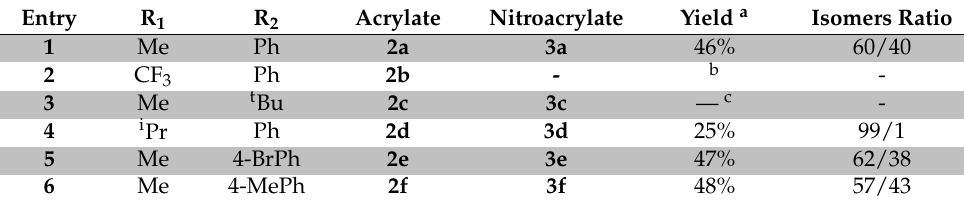
Table 2. Synthesis of tetrasubstituted nitroalkenes 3a – f .